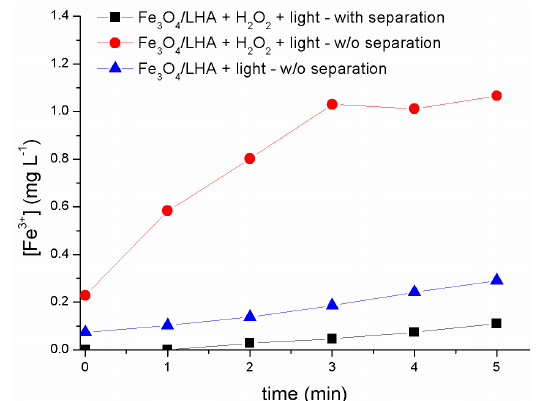
Figure 3. Fe 3+ profiles measured in the absence and in the presence of H 2 O 2 , with and without the nanoparticle’s separation step. (CBZ) 0 = 2 mg L − 1 ; (Fe 3 O 4 /LHA) 0 = 500 mg L − 1 ; (H 2 O 2 ) 0 = 0.015 mM; pH 3.0.